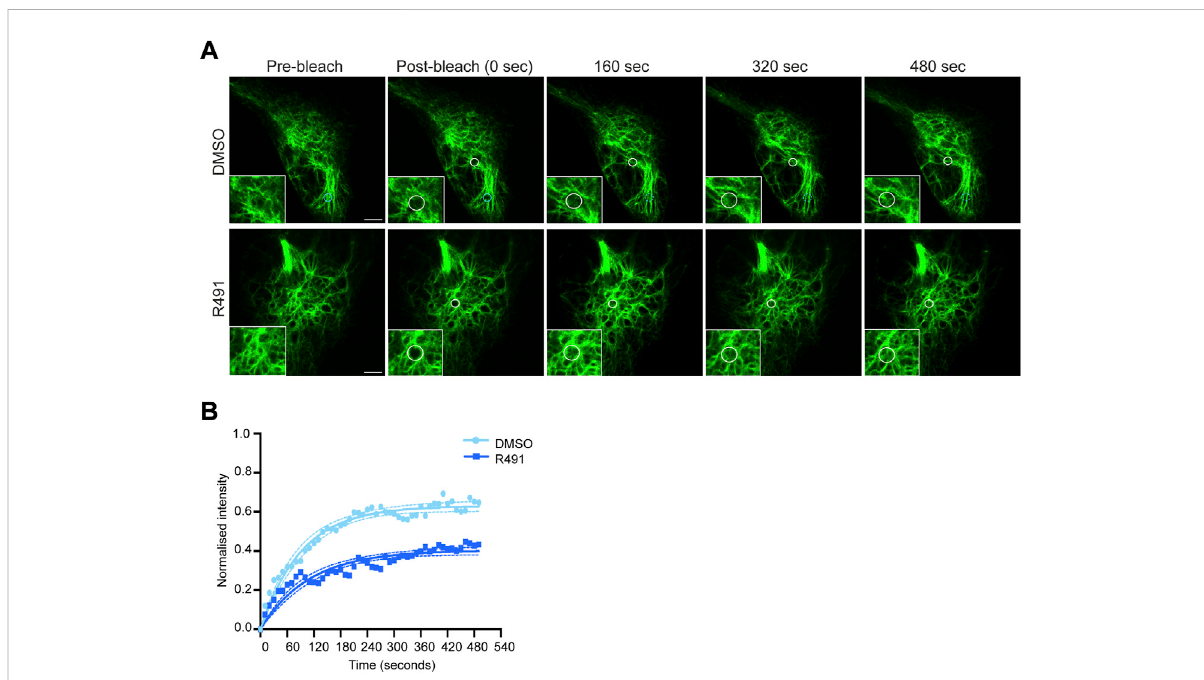
FIGURE 2 R491-treatment stabilizes vimentin in BJ-Ras cells. (A) Representative FRAP images of cells treated with 5 µM control or R491 3 h prior to imaging. Inset images show magni fi ed views of the bleached areas in the larger images. The FRAP-bleached regions are shown in white circles over time. The blue circle in the top panel indicates a FRAP-bleached region near the cell periphery, in which vimentin fi laments moved and therefore weredif fi culttotrack(dottedbluecircles),andexcludedfromthedataset. (B) FRAPrecoverycurvesofvimentin-EGFPincellstreatedwith5 μ M control (light blue, n = 14) or R491 (dark blue, n = 13), showing themeansof atleast3 biological repeats. One-phase exponential recovery curve was fi tted (solid line), and 95% con fi dence intervals are shown (dotted lines). **** p ≤ 0.0001 drug treated compared with control plateau (Ymax). p = 0.319 for drug-treated as compared with control Rate of recovery (K). Scale bar: 5